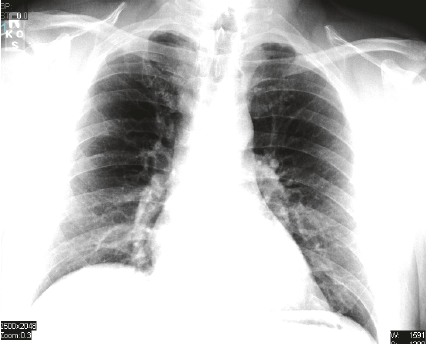
Figure 2: Chest X-ray seven days after